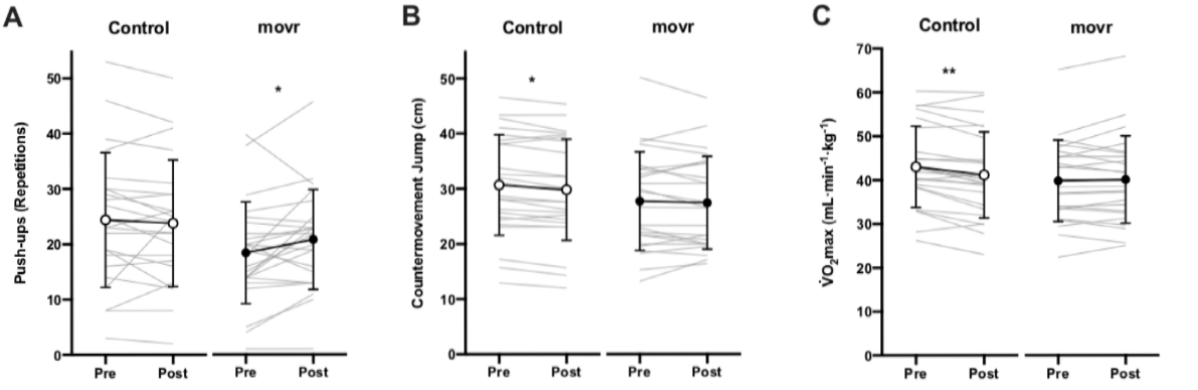
Figure 2. Measurements of (A) push-ups, (B) countermovement jump, and (C) maximal oxygen uptake (<inline-graphic xlink:href="mhealth_v9i5e24076_fig3.png" xlink:type="simple" mimetype="image"/>) before (pre) and after (post) the 8-week intervention period. Circles with black connecting lines represent sample means with SD error bars, whereas gray lines represent individual participant data points. Asterisks indicate significant differences between pre- and postintervention values within a given group (* P <.05; ** P <.01).